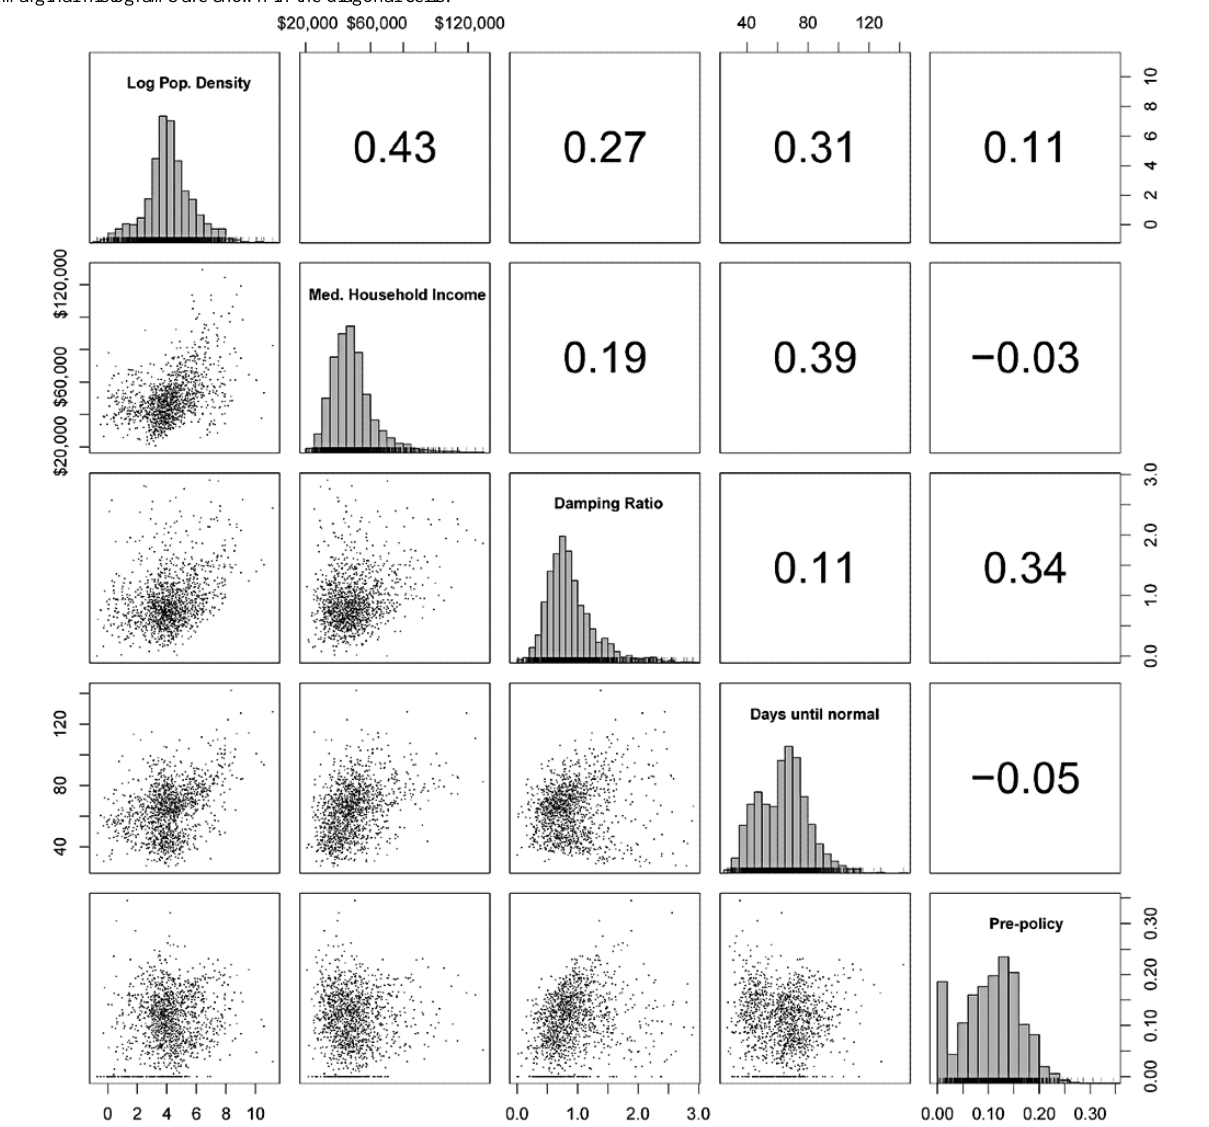
Figure 3. Scatter plots of county-level mobility dynamics with two demographic covariates. Spearman correlations are given in the upper-right triangle and marginal histograms are shown in the diagonal